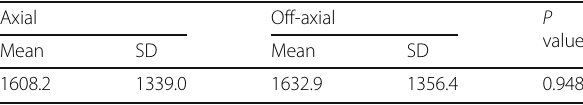
Table 4 Descriptive statistics and results of comparison between microstrains induced by the two load directions regardless